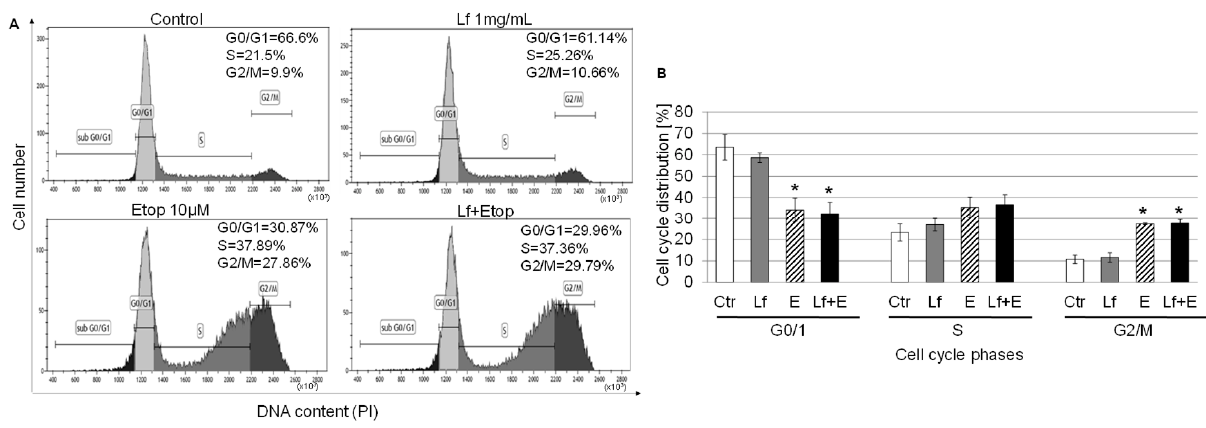
Figure 4. Effect of rhLf in combination with etoposide on A549 cell cycle progression. A549 cells were treated with rhLf (Lf) and etoposide (E) alone or the combination (Lf + E) at indicated concentrations for 24 h. ( A ) Representative histograms show the cell cycle distribution at G0/1, S, and G2/M phases in the control and treated cells. ( B ) The bar graph indicates the percentage of cells at each phase of cell cycle in the control cells (Ctr) and cells after indicated treatments. The data are expressed as the mean ± SD of three experiments. * p < 0.05 compared to the